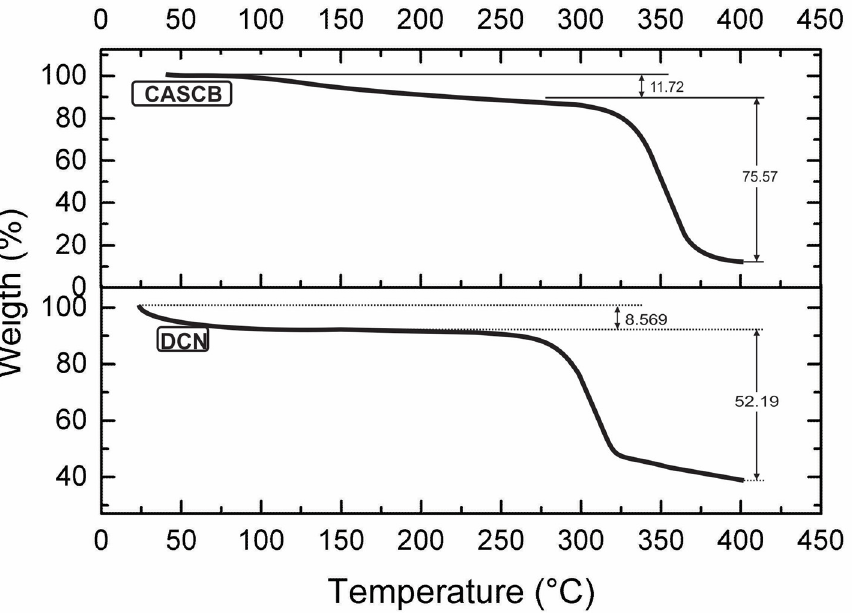
Figure 3. Thermograms of cellulose acetate from sugarcane bagasse (CASCB) and dyed cellulose fibers (DCN). fibers (DCN).